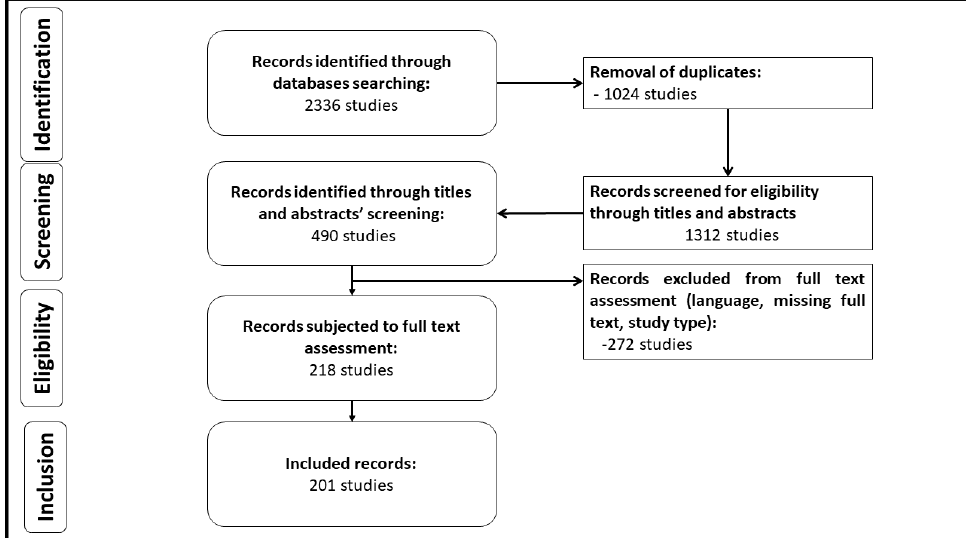
Figure 1. Literature search flow